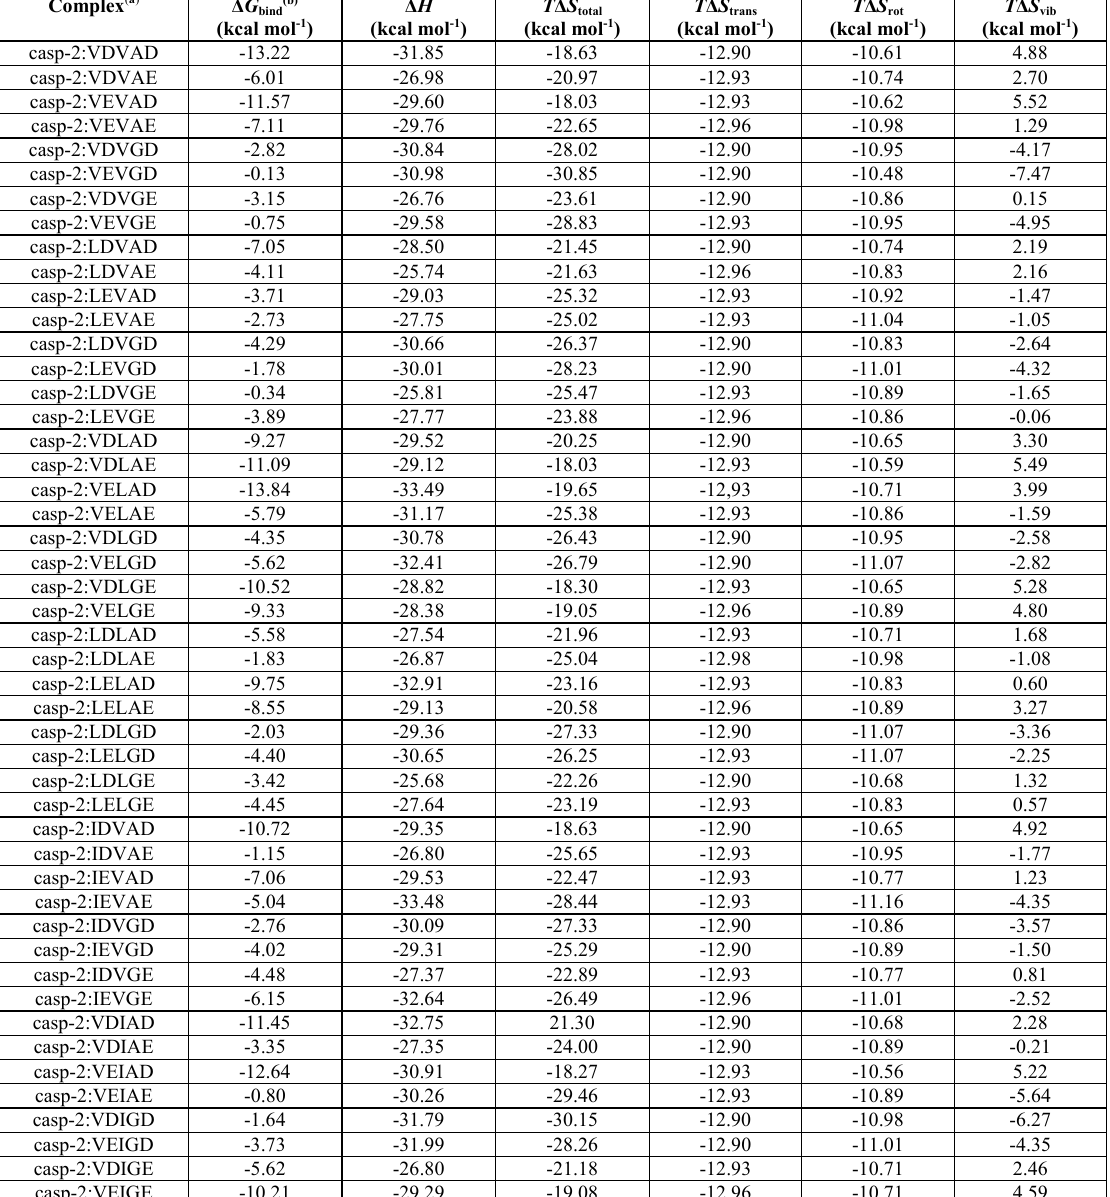
Table S1. QM/MM binding free energies for caspase-2:peptide